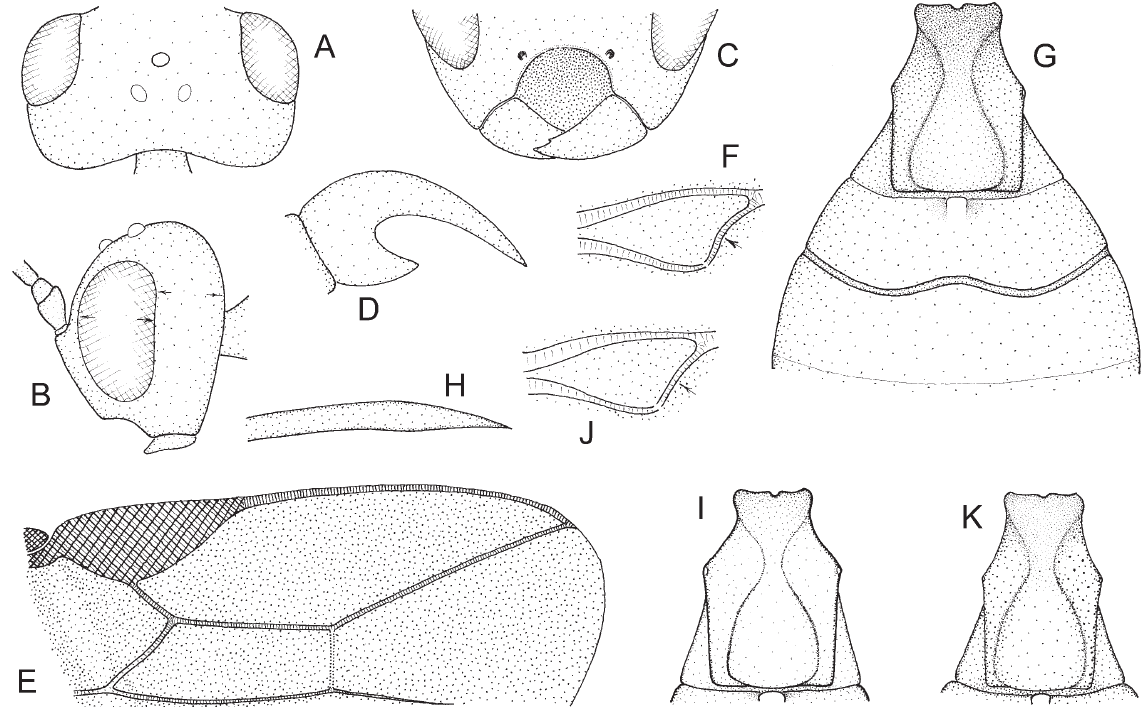
Fig. 1. Bracon ( Glabrobracon ) colpophorus Wesmael, 1838 (A-H: ♀ holotype). A . Head in dorsal view. B . Head in lateral view. C . Head in frontal view. D . Claw. E . Distal part of right forewing. F . cu-a of hindwing. G . Tergites 1-3. H . Hind end of ovipositor. I . First tergite of ♀. J . cu-a of hindwing of ♀ + ♂. K . First tergite of